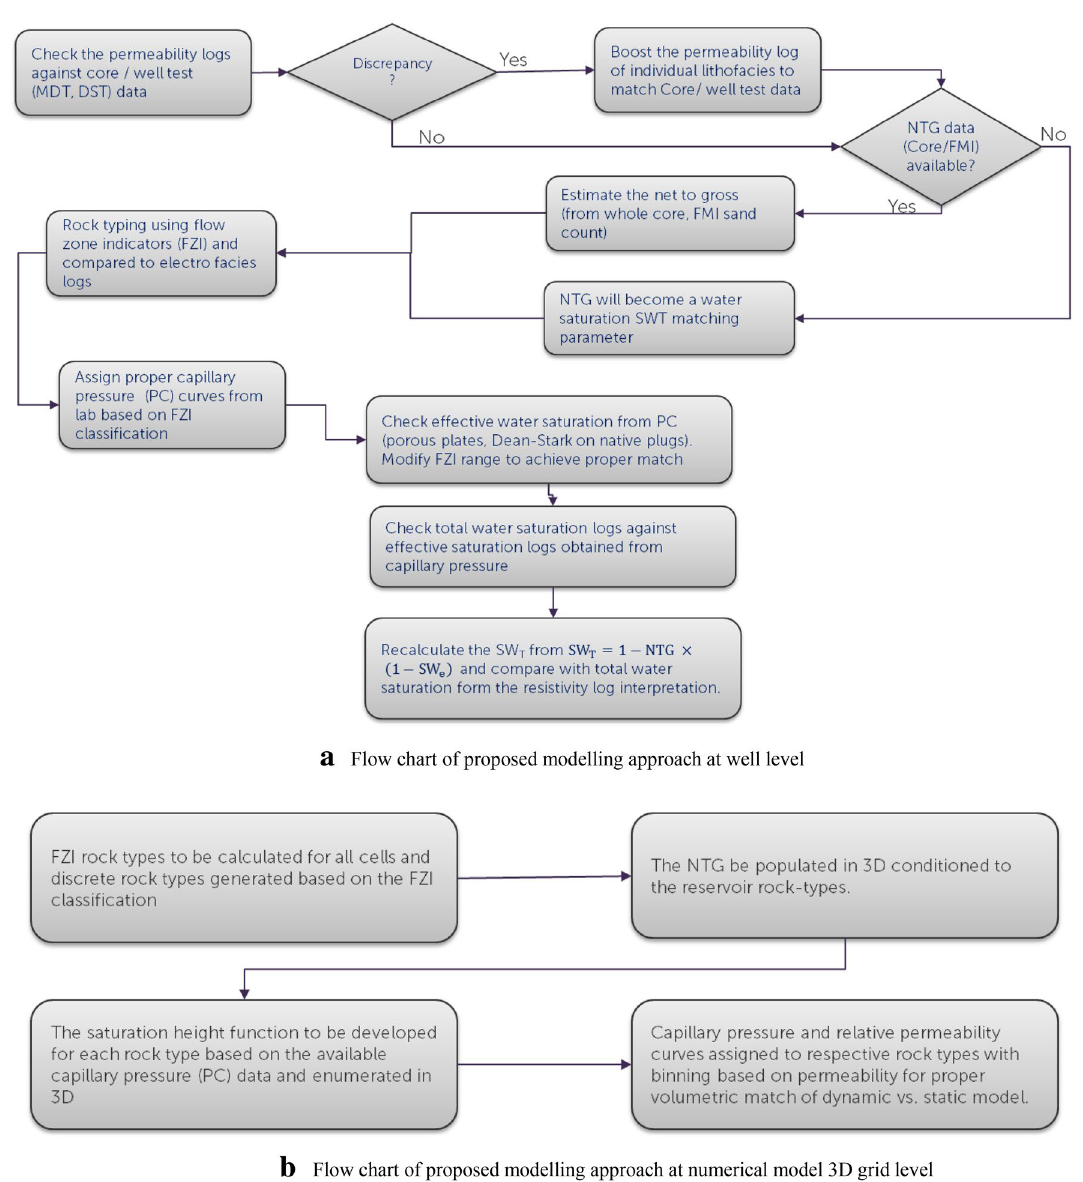
Fig. 8 a Flow chart of proposed modelling approach at well level. b Flow chart of proposed modelling approach at numerical model 3D grid